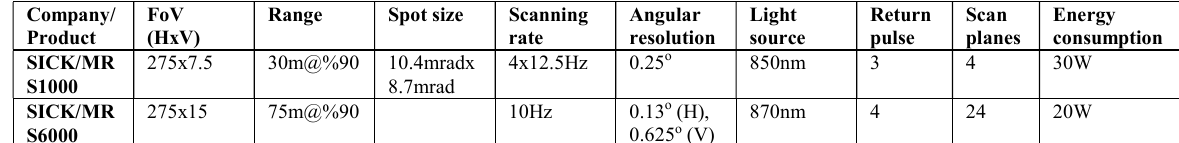
Table 4. The specifications of multi-layer LiDAR instruments.